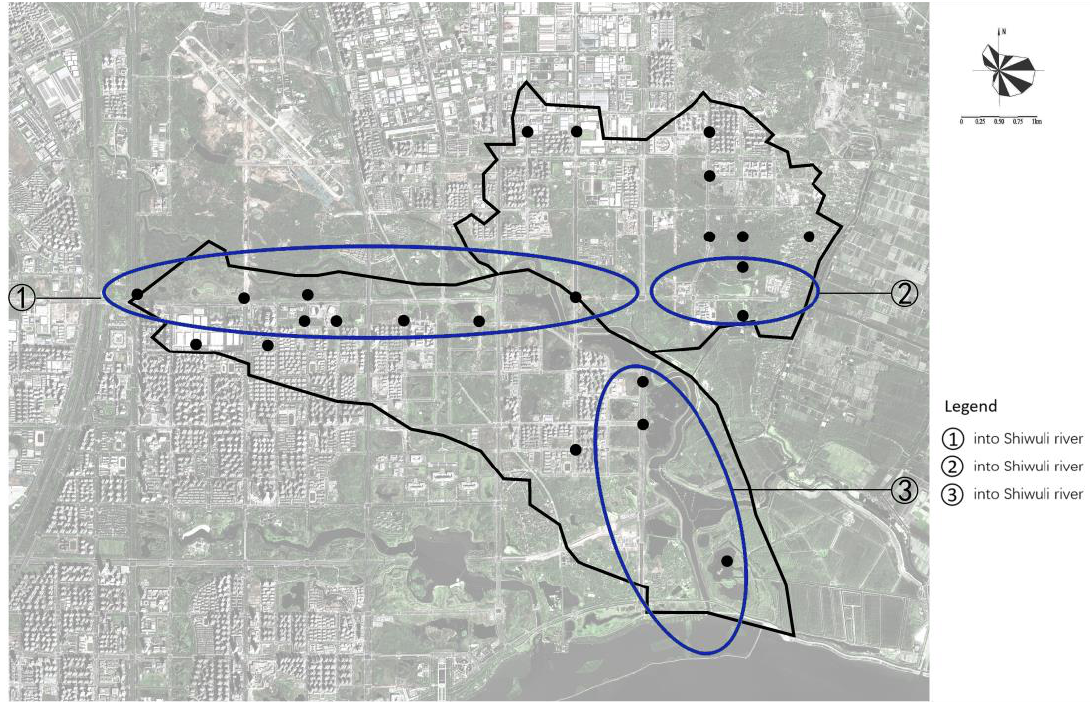
Figure 7. The region of blue-green transformation planning in the lower stream.